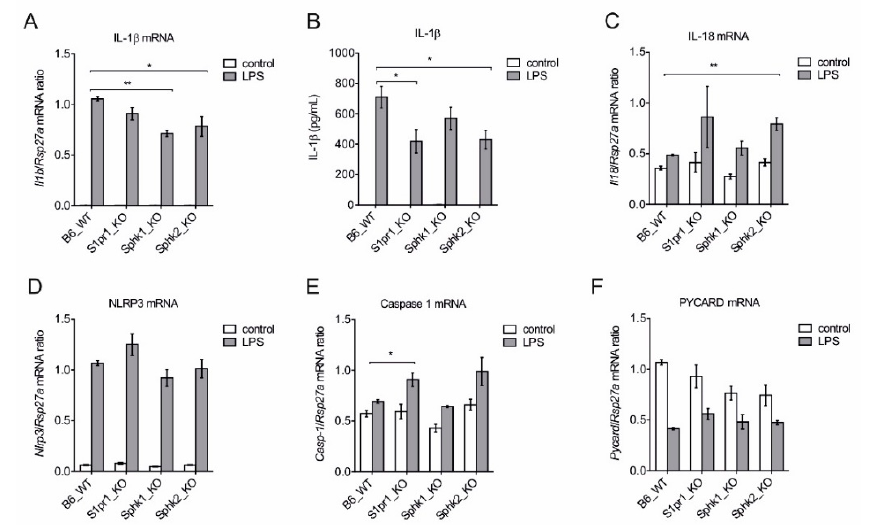
Figure 3. Relative contribution of Sphk1 , Sphk2, and S1pr1 in the expression of individual NLRP3 inflammasome components. BMDMs from B6 WT, S1pr1 -LysM-Cre mice, Sphk1 KO, and Sphk2 KO mice were stimulated with 100 ng/mL LPS for 3 h before mRNA expression analysis by qPCR..